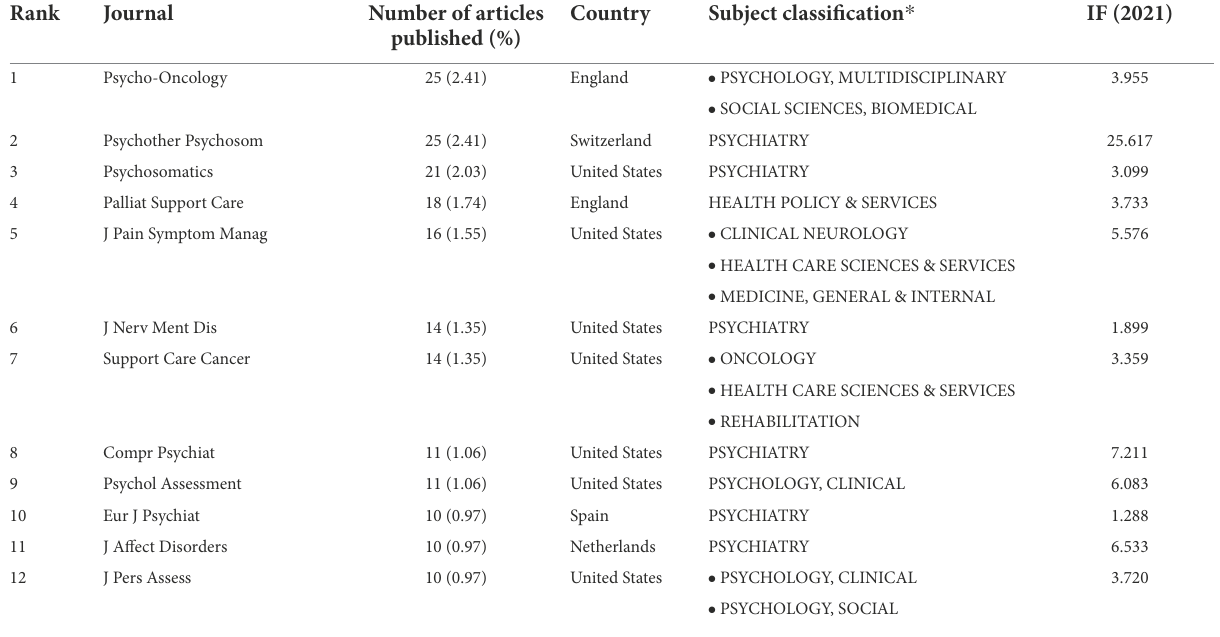
TABLE 1 Journals with 10 or more articles on